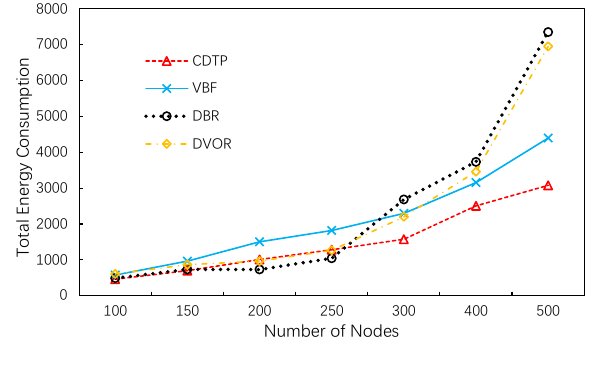
Figure 9. Energy consumption.